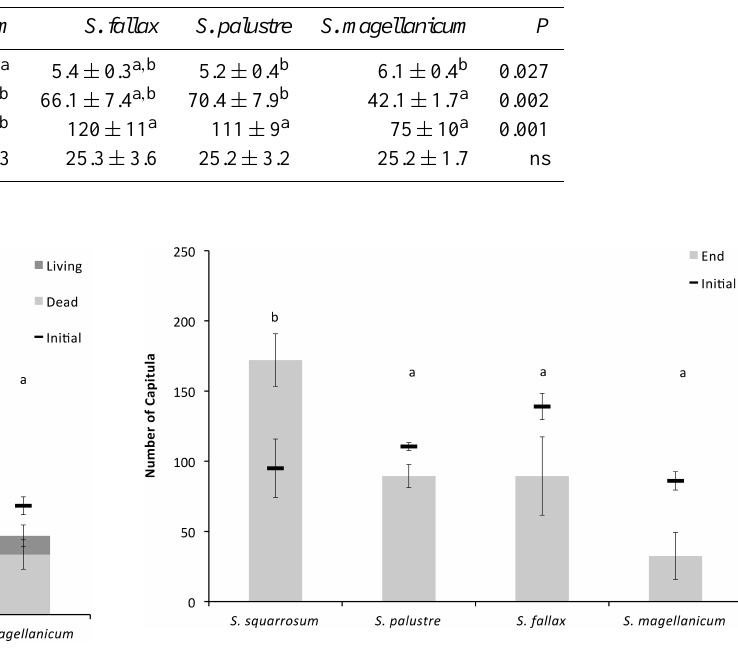
Figure 2. Number of capitula ( ± SEM) produced by a patch of 50cm 2 of four different Sphagnum species after 12 weeks of ex- perimental treatments (grey bars). The smaller black bars depict the number of capitula at the beginning of the experiment. Significant differences in the final number of capitula between the species are indicated by different letters ( P =